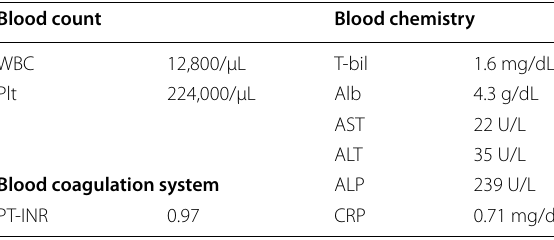
Table 1. Laboratory results Blood count Blood